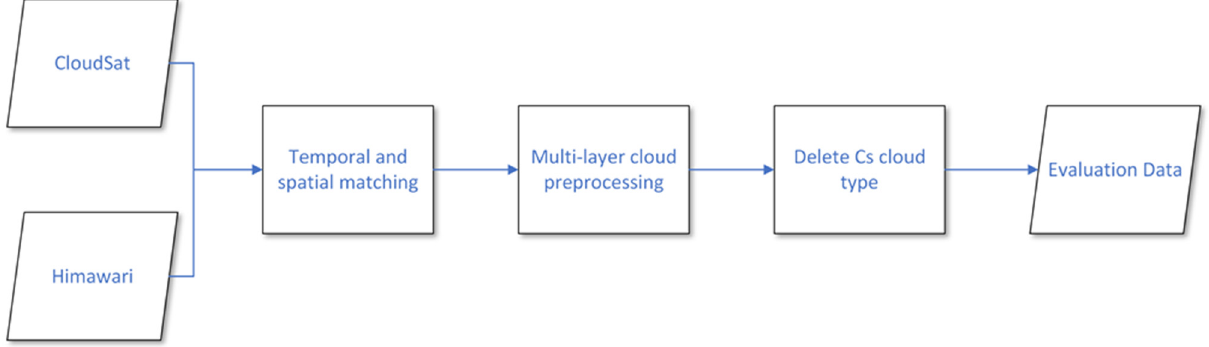
Figure 4. The CloudSat data preprocessing process.